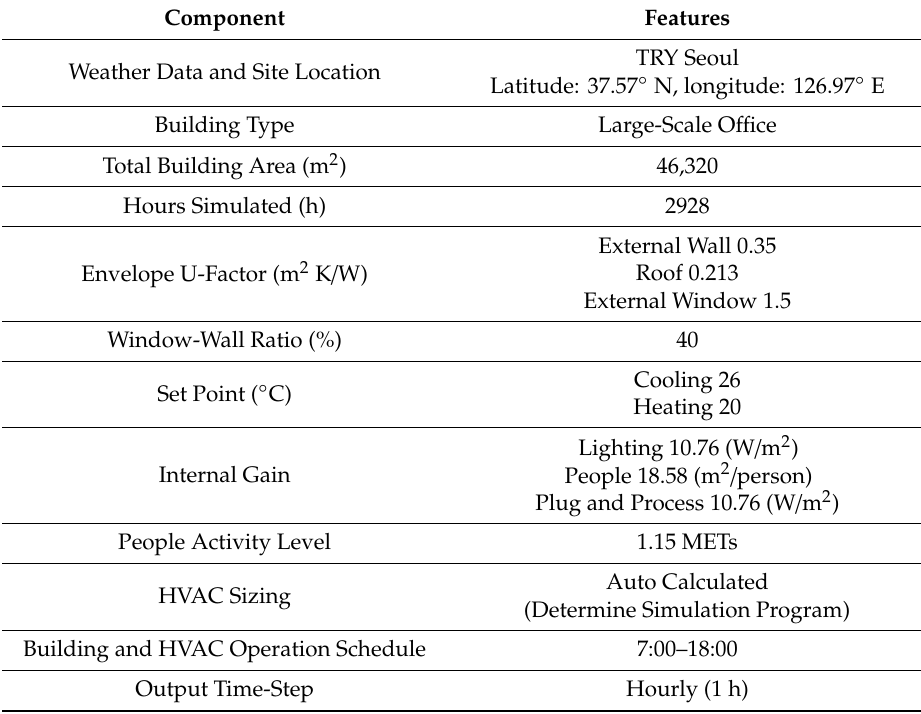
Table 1. Simulation conditions of the reference building: Large-scale o ffi ce building [12].